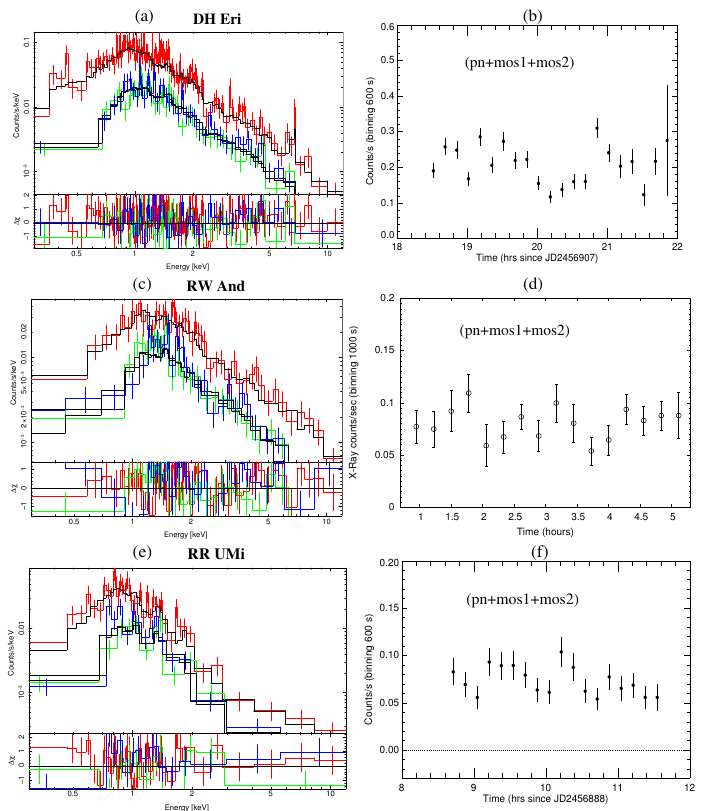
Figure 1. X-ray spectra (colored curves: XMM-Newton/EPIC pn,red; MOS1,green; and MOS2,blue) and model fits (black curves) of the fuvAGB stars DHEri, RWAnd and RRUMi (panels a , c , e ), and X-ray light curves (black symbols) (panels b , d , f ). As for most fuvAGB stars, DHEri and RW And are each fitted by a single hard component (Tx ∼ 5 × 10 7 K) (panels a & C, respectively), but in RRUMi (panel e ) the dominant emission component has Tx that is significantly lower (Tx(1) ∼ 6.6 × 10 6 K); a weaker harder component (Tx(2) ∼ 10 8 K) is also present ( adapted from Sahai, Sánchez Contreras and Sanz-Forcada 2018, in prep.